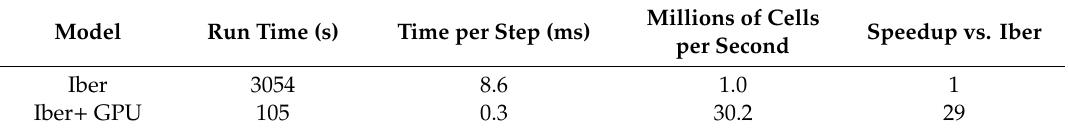
Table 3. Performance measurements obtained for the third test case (Miño River, NW Spain). Model Run Time (s) Time per Step (ms)